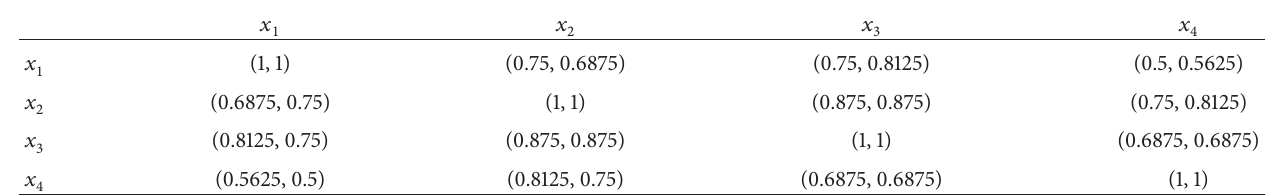
Table 4: Consensus levels of preference values provided by 𝑒 1